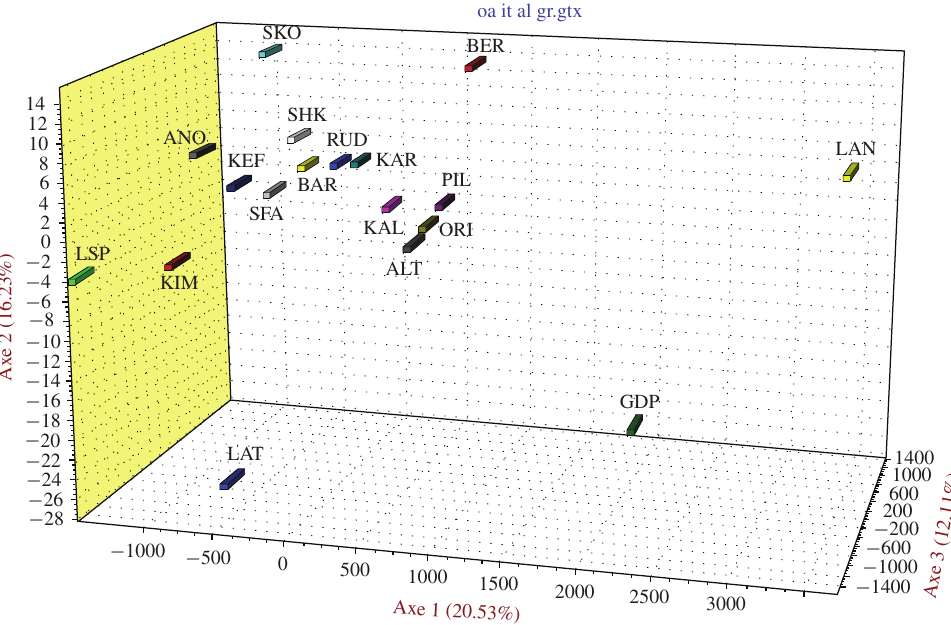
FIGURE 4: PCA analysis of the breeds assessed by SNP markers. The first three axes, cumulatively ex- plaining 48.87 % of the total inertia, were